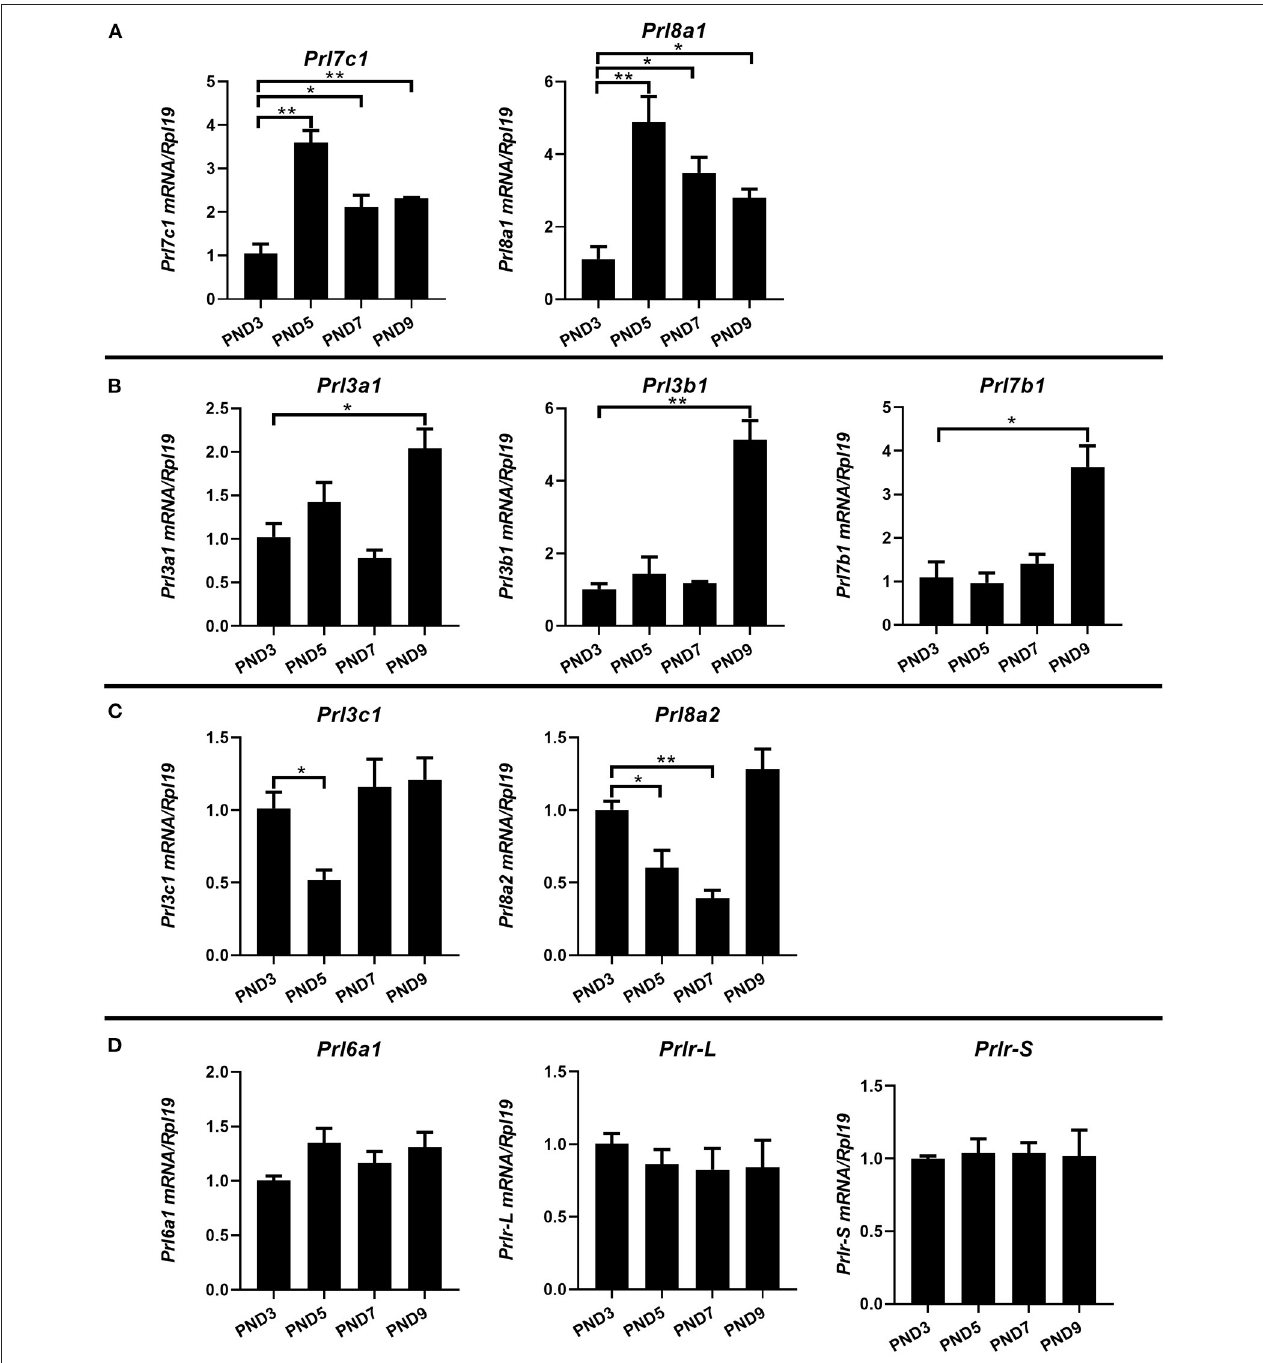
FIGURE 3 | Quantitative Real-time-PCR analysis of Prl3a1, Prl3b1, Prl3c1, Prl6a1, Prl7b1, Prl7c1, Prl8a1, Prl8a2, and Prlr ( Prlr-L and Prlr-S ) mRNA levels in the endometrium of neonatal mice during the early postpartum period. The mRNA expression of Prl7c1 and Prl8a1 were up-regulated on PND5, and then down-regulated on PND7 and PND9 (A) . Prl3a1 , Prl3b1 , and Prl7b1 genes increased on PND9 (B) . Prl3c1 and Prl8a2 genes decreased on PND5 (C) . The expression of Prl6a1 and Prlr ( Prlr-L and Prlr-S ) were stable from PND3 to PND9 (D) . Results are means ± SEM ( n = 5). Bars with different superscripts are significantly different ( P <